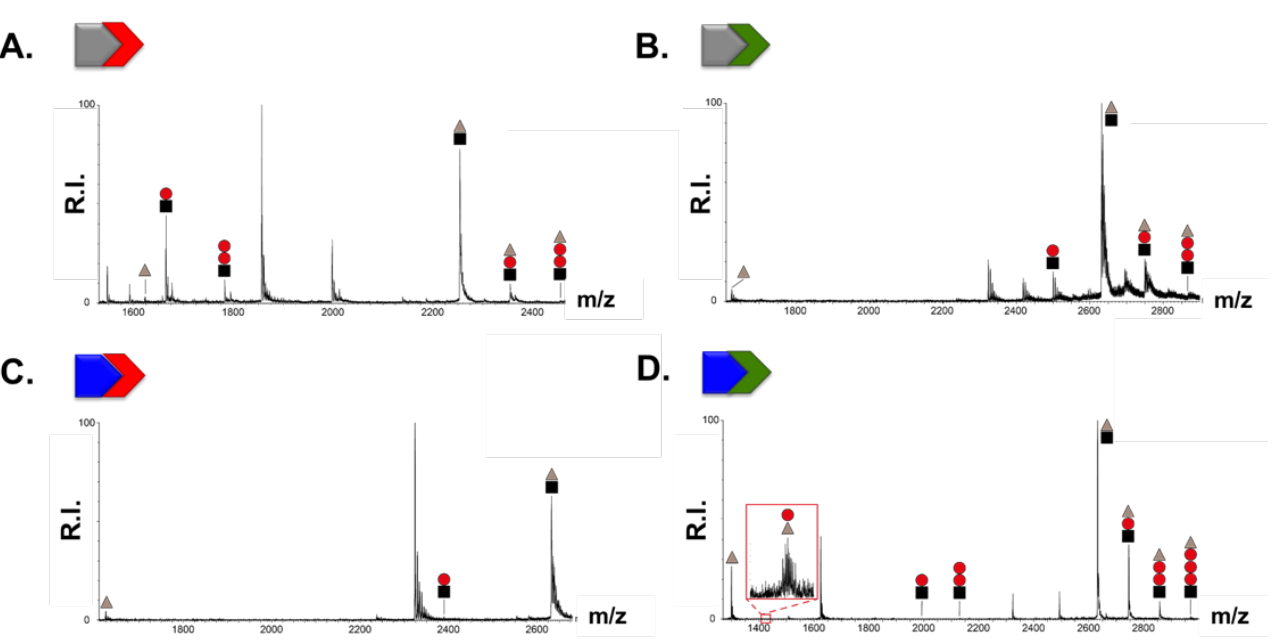
Figure 5. ESI- MS spectra of samples obtained by adding NC to the preformed ligand•TAR com- Figure 5. ESI-MS spectra of samples obtained by adding NC to the preformed ligand • TAR plexes. The tested compounds are ( A ) β -Ala-Y, ( B ) β -Ala-DY, ( C ) G-Y and ( D ) G-DY. Lower inten- sity signals near free/bound species consist of typical sodium and ammonium adducts. Grey ▲ cor- responds to NC protein; black ■ to the TAR RNA substrate; and red to the ligand. For the sake of clarity, only the 5+ and 6+ charge states of the binary (RNA-ligand) and ternary (RNA-ligand – pro- tein) complexes are labeled in the spectra.